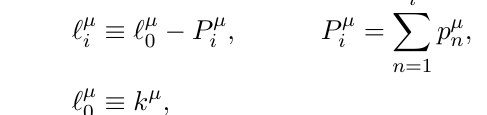
Figure 4 . The complete set of cuts for B [ L ] (1